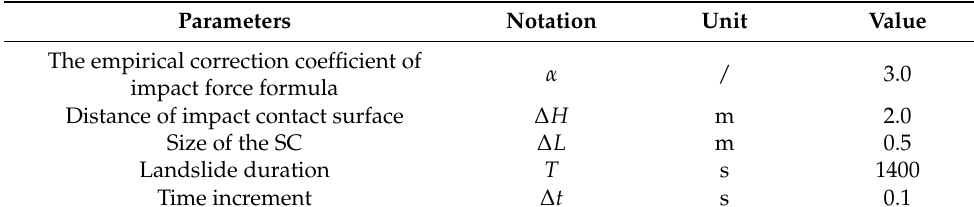
Table 2. Parameters used in the impact force estimation.